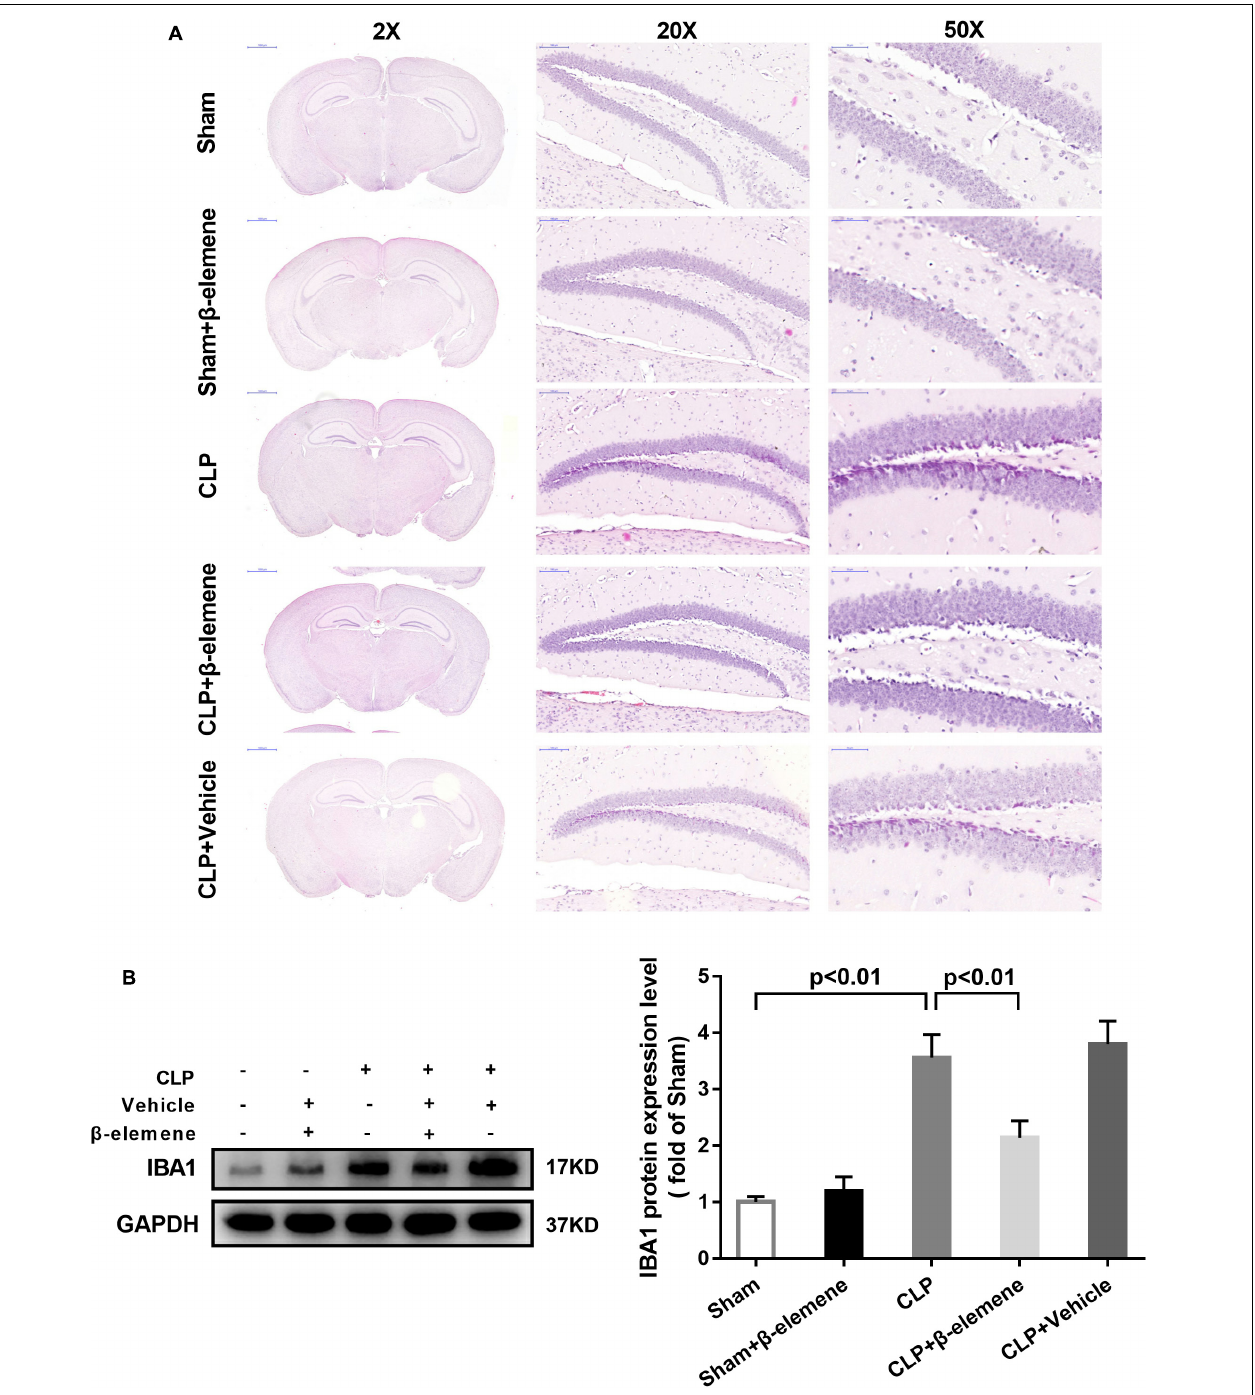
FIGURE 4 | β -Elemene reduced the expression of the microglial marker IBA1 in the hippocampus of CLP mice. (A) Images of HE-stained brains from sham and β -elemene groups. Magnification: 20, 200, or 500 × . (B) β -Elemene reduced IBA1 expression in the hippocampus normalized to that of GAPDH. F(4, 15) = 46.08. n = 4. One-way ANOVA revealed a significant difference at p <